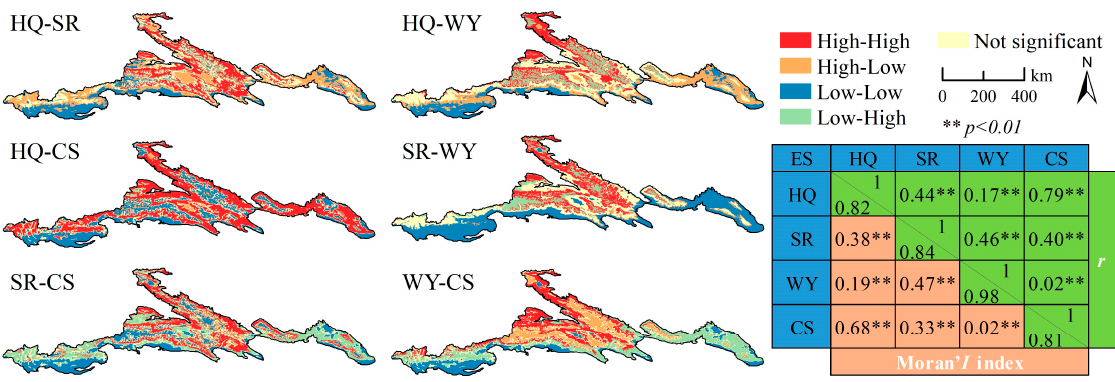
Figure 5. The trade-offs and synergies of ESs in the Tianshan mountains. The results of the bivariate spatial autocorrelation analysis further revealed the spatial patterns of trade-offs and synergies between different ESs from 2000 to 2020. Synergies were dominant in the HQ–SR pair, covering 44.71% of the study region. High–high aggregation areas were mainly concentrated in the central Tianshan Mountains, whereas low–low aggregation areas were mainly distributed in the eastern and southern Tianshan